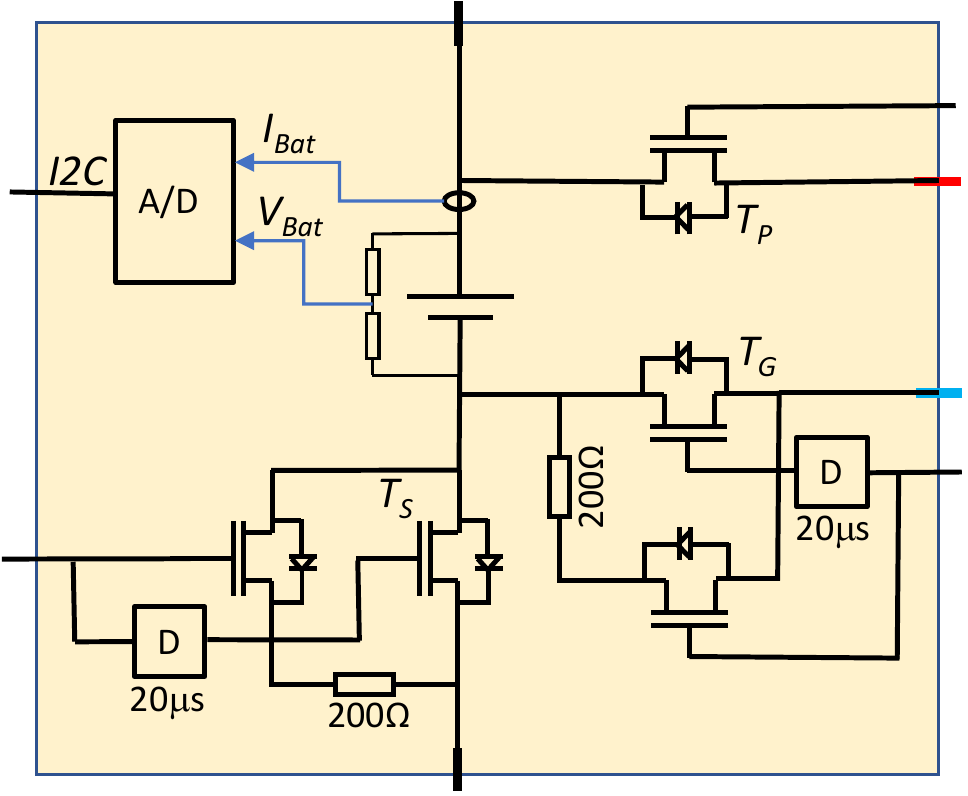
Figure 3. Schematic of reconfiguration module. An I2C A/D converter measures battery module’s voltage and current. During configuration switching, low-ohmic, high-current switches are delayed by 20µs to let inrush-current limiters equalize voltage